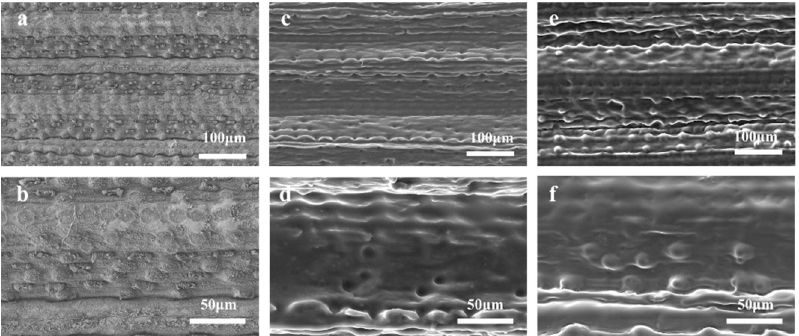
Figure 7. SEM photographs of ( a , b ) original PCL, ( c , d ) negative polydimethylsiloxane (PDMS) replica; ( e , f ) positive PDMS replica.